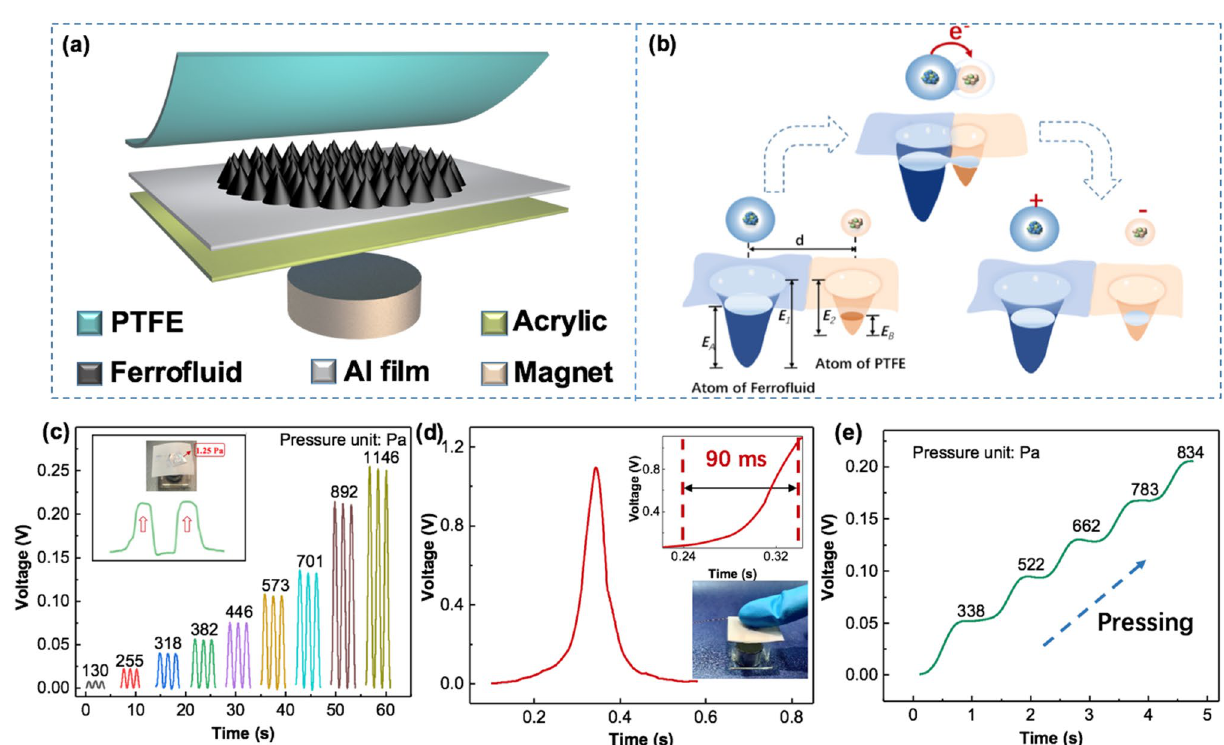
Fig. 2 Basic structure and sensing properties of FTTS. a Schematic illustration of the FTTS. b Explanation of contact electrification phenom- enon by electron cloud interaction. c Output voltage of the FTTS under varying static pressures imposed by copper probe. The inset shows low detection limit of 1.25 Pa. d Response time of the FTTS. The inset above is a partial enlargement of the curve. The inset below is demonstration of pressing. e Real-time output voltage changing under dynamic variable